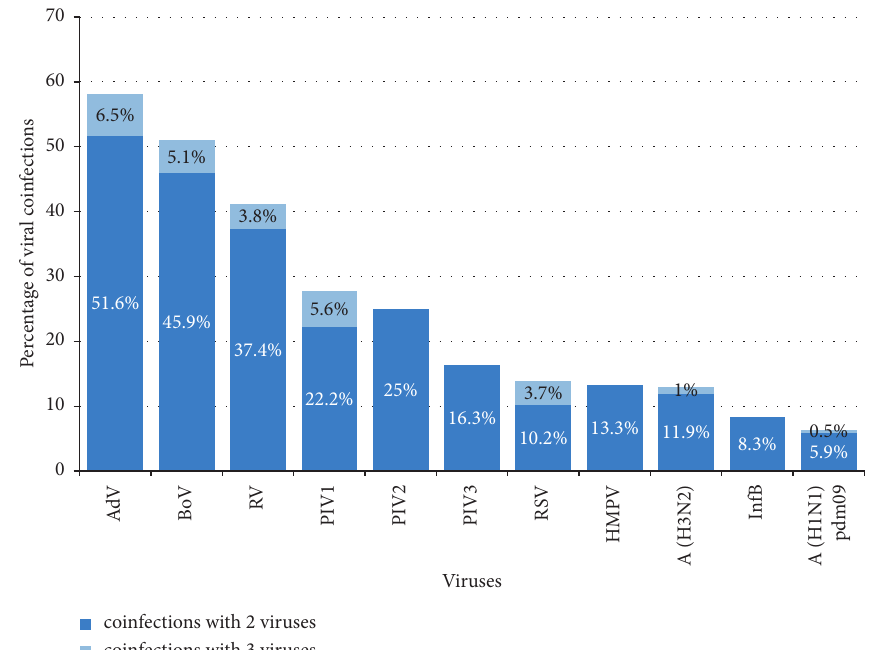
Figure 2: Distribution of identified respiratory viruses in cases of coinfections. The percentage of coinfections was calculated based on the total number of infections for each virus.